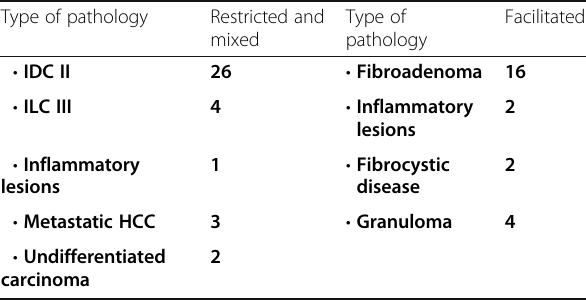
Table 6 The relation of the type of diffusion and the